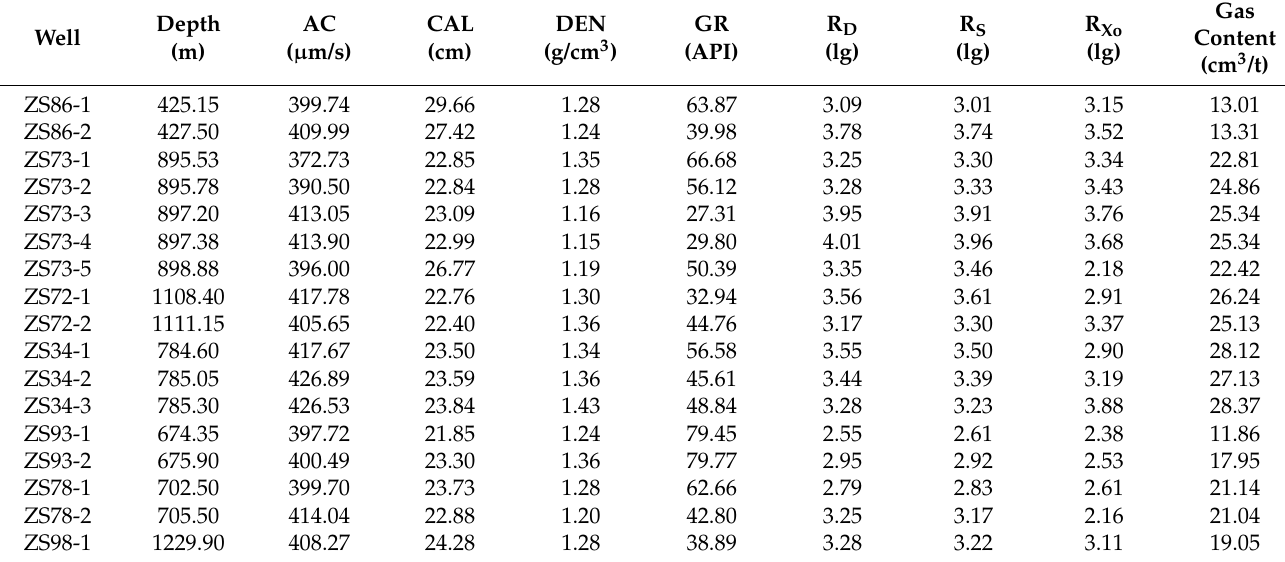
Table 1. Part of logging data and measured gas content in Zhengzhuang